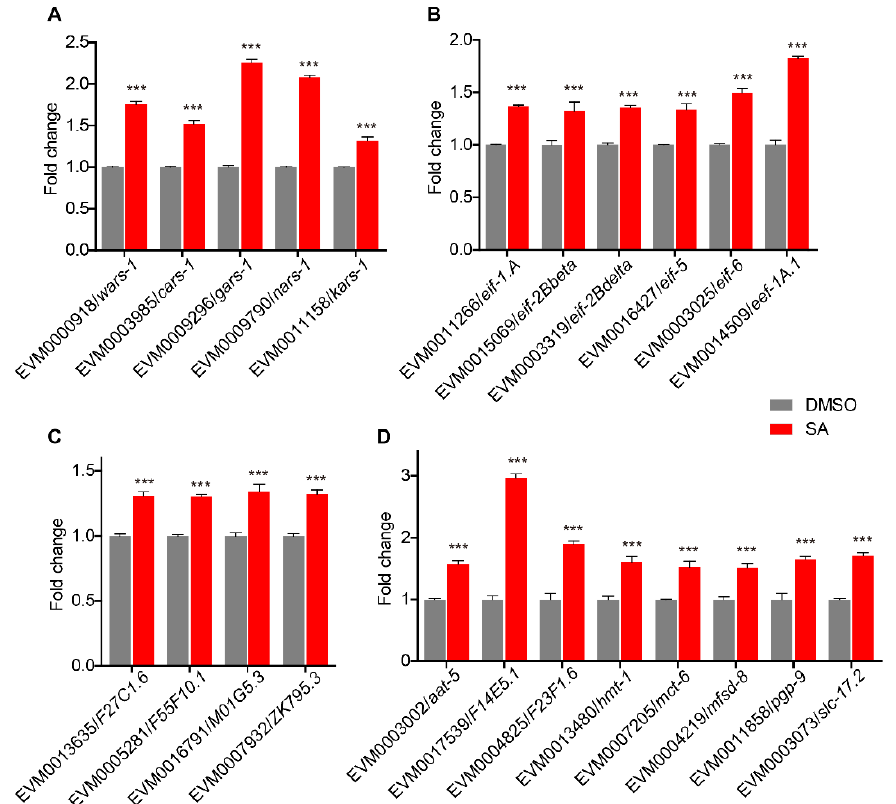
Figure 5. Expression of related upregulated pathway genes. ( A ) Expression level of aminoacyl-tRNA biosynthesis genes. ( B ) Expression level of translation initiation and elongation factors genes. ( C ) Expression level of ribosome biogenesis-related genes. The expression level of upregulated gene EVM0003025/ eif-6 enriched in this term is presented in ( B ). ( D ) Expression level of some transmembrane transporters-related genes. SA (stearic acid). The error bars represent SEM of the mean. *** p adj < 0.001.